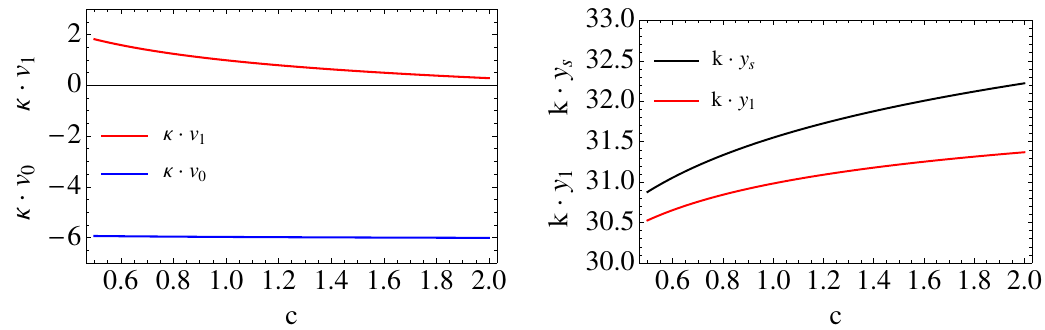
Figure 2 . Left panel: (cid:20)v 0 and (cid:20)v 1 as a function of the parameter c . Right panel: location of the IR brane, ky 1 , and singularity, ky s , as a function of the parameter c . We have used A 1 = 35 and p (cid:23) = (cid:20)=